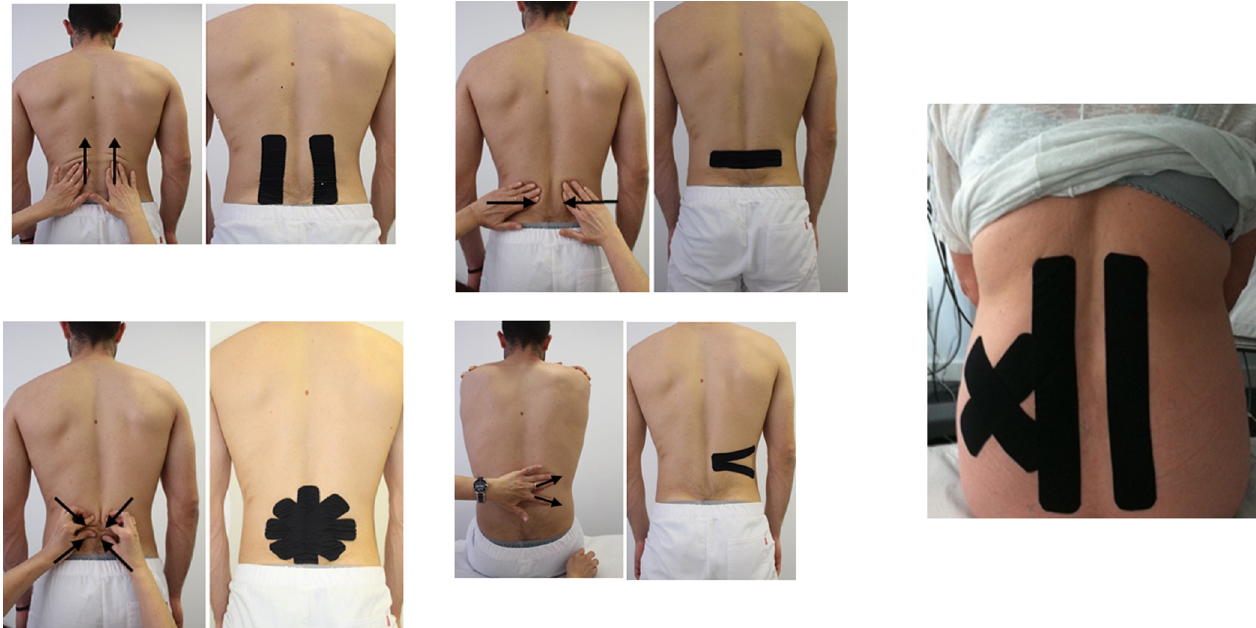
Fig 2. Targeted therapy with kinesio taping: The arrows indicate the direction of the skin/fascia mobilization. A) Muscle technique, with application starting from the upper region and extending down over the paravertebral muscles. B) Transversal space technique with application at the segmental level. C) Star space technique with application at the segmental level. D) Fascia technique with application over the muscular band of the quadratus lumborum. E) Muscle technique over the paravertebral muscles and X space technique over the iliac crest.